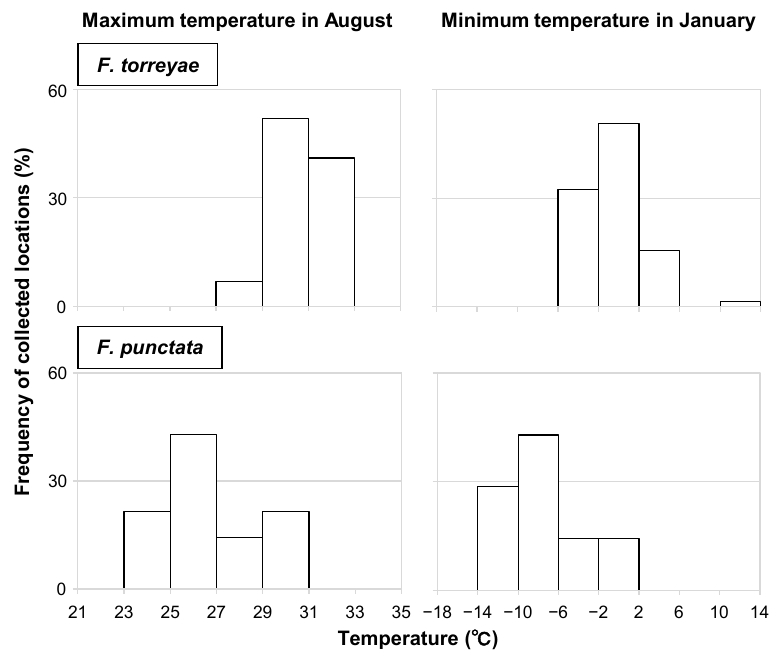
Figure 4. Frequency of collection locations of Fomitiporia torreyae and Fomitiporia punctata at different levels of maximum temperature in August and minimum temperature in January.